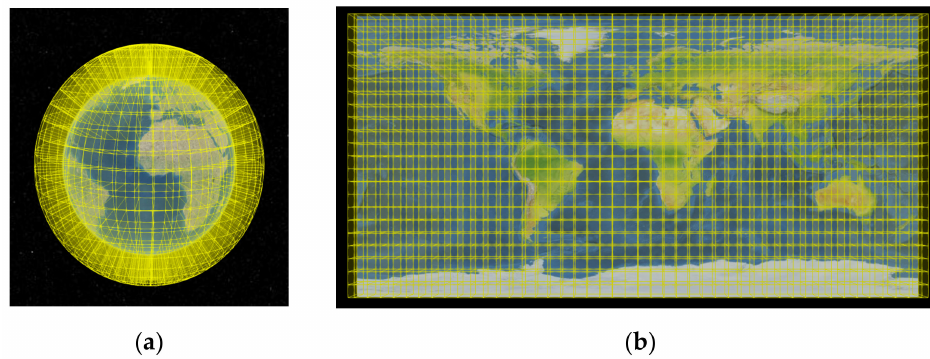
Figure 12. GeoSOT global grid display ( a ) 3D display; ( b ) 2D display.